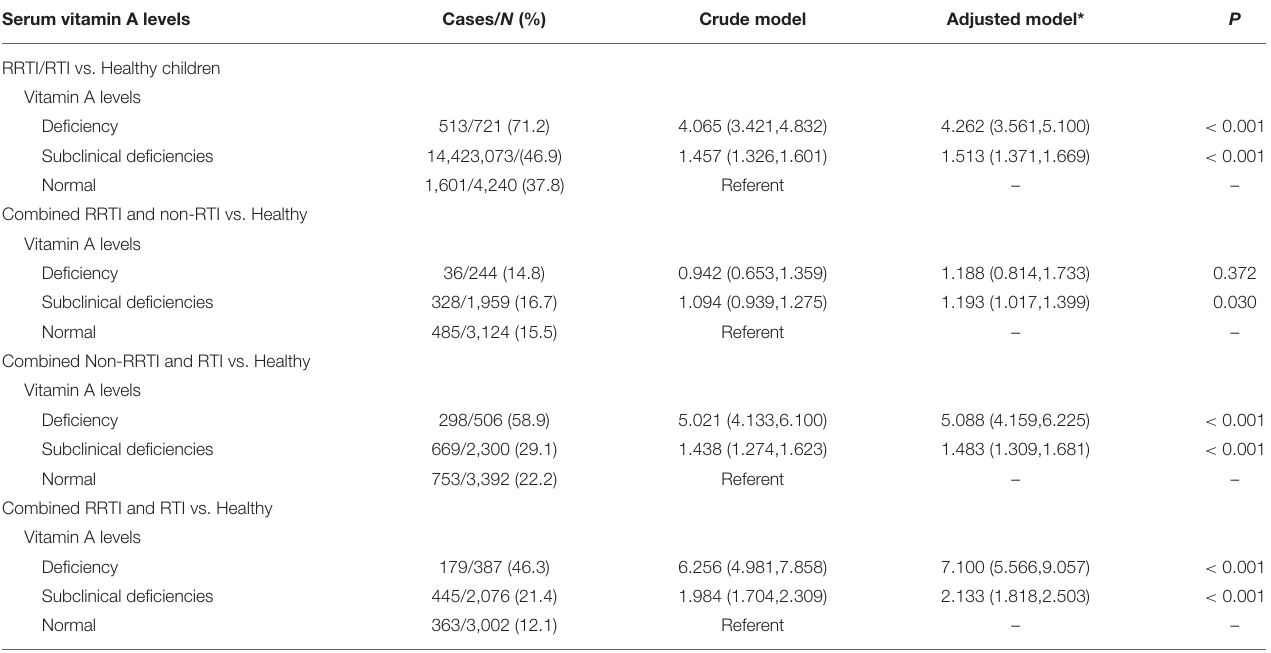
TABLE 2 | Associations between serum vitamin A levels and risk of recurrent respiratory infections in children aged 0.5–17 years in Beijing. Serum vitamin A levels RRTI/RTI vs. Healthy